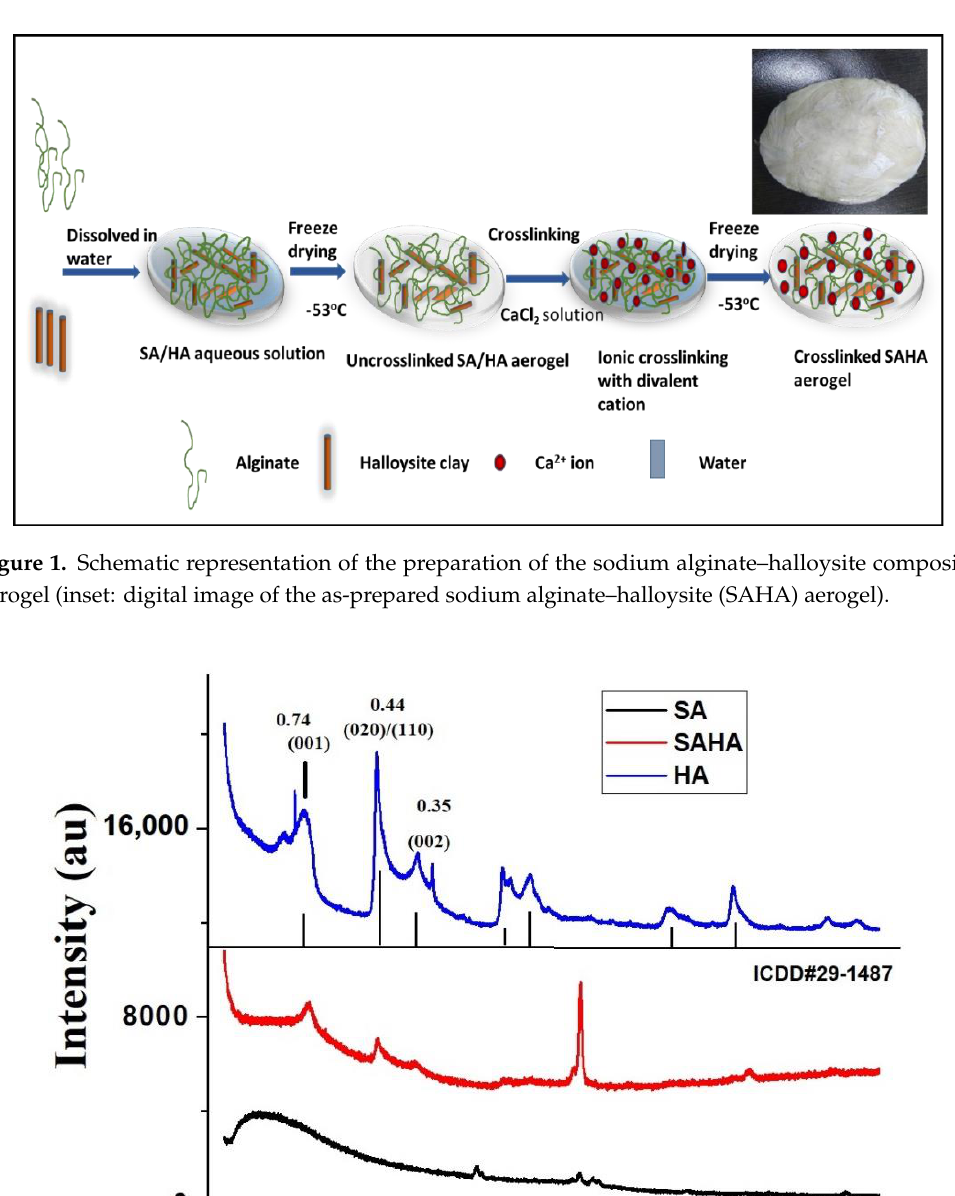
Figure 1. Schematic representation of the preparation of the sodium alginate–halloysite composite aerogel (inset: digital image of the as-prepared sodium alginate–halloysite (SAHA) aerogel).